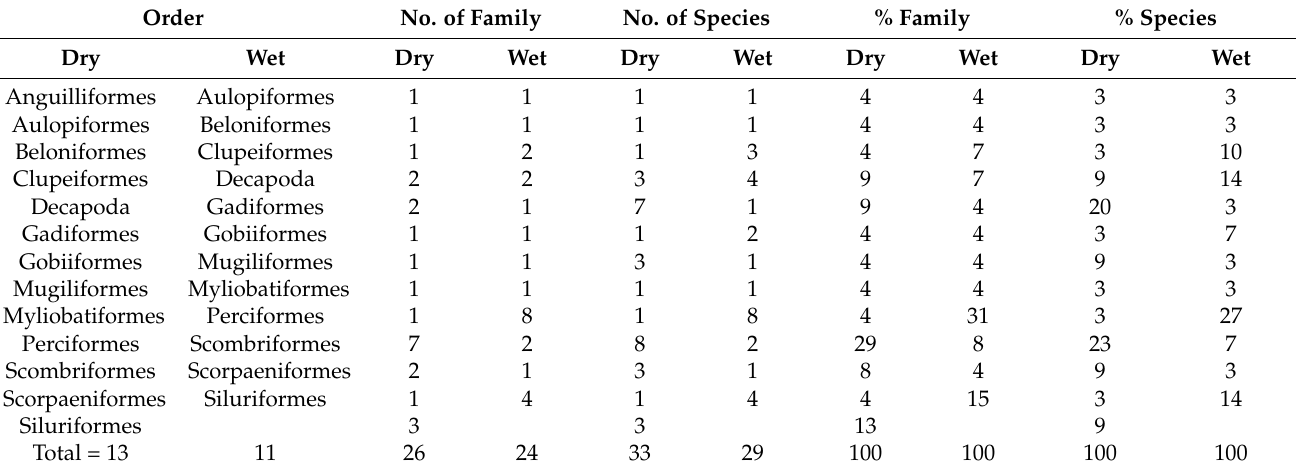
Table 3. Number and percent composition of families and species under various orders of fishes recorded in the Meghna River estuary